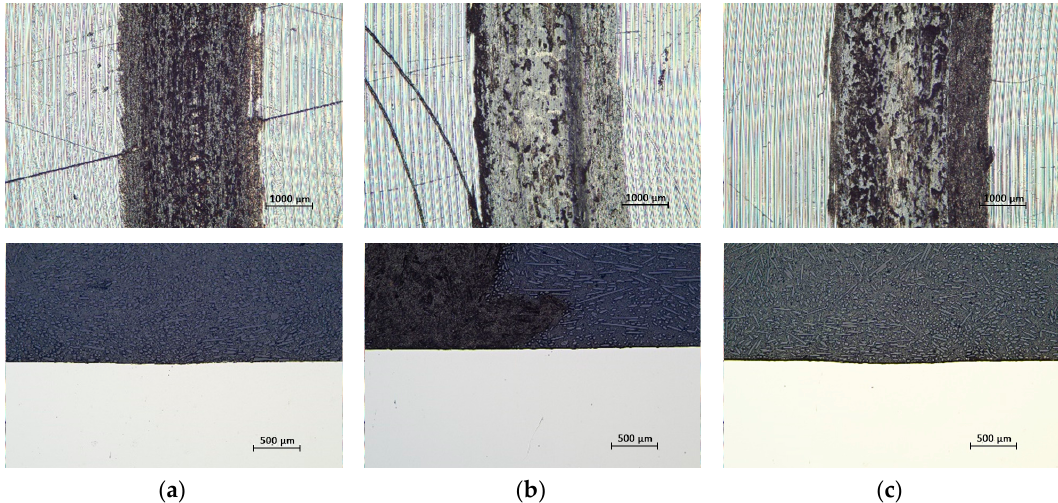
Figure 7. Worn surfaces and cross section of the traces of tribological pair at friction speed (m/s): ( a ) 0.2, ( b ) 0.4, ( c ) 0.6.